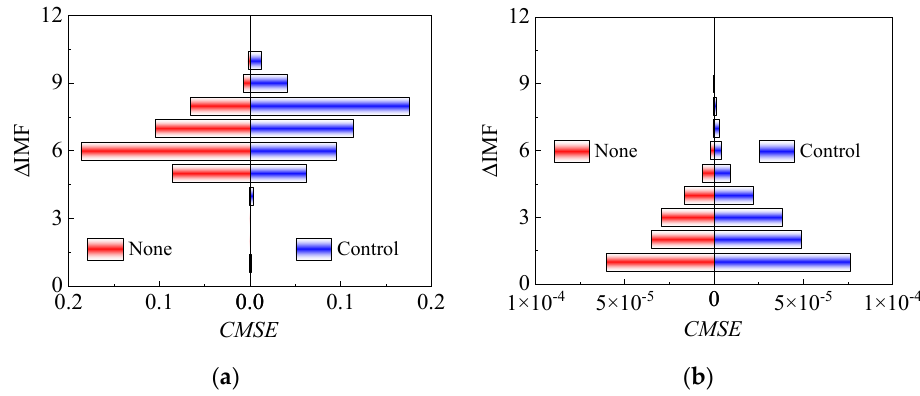
Figure 12. The difference between adjacent intrinsic mode function: ( a ) Mode 1; ( b ) Mode 500. Figure 13 indicates the comparison results of the reconstructed time sequence and the original time coefficient in the first-order mode. No matter what case, the reconstructed series shows a very high degree of coincidence with the original time coefficients. The correlation coefficient is close to one, and the relative error does not exceed 1%, which meets the expected requirements.